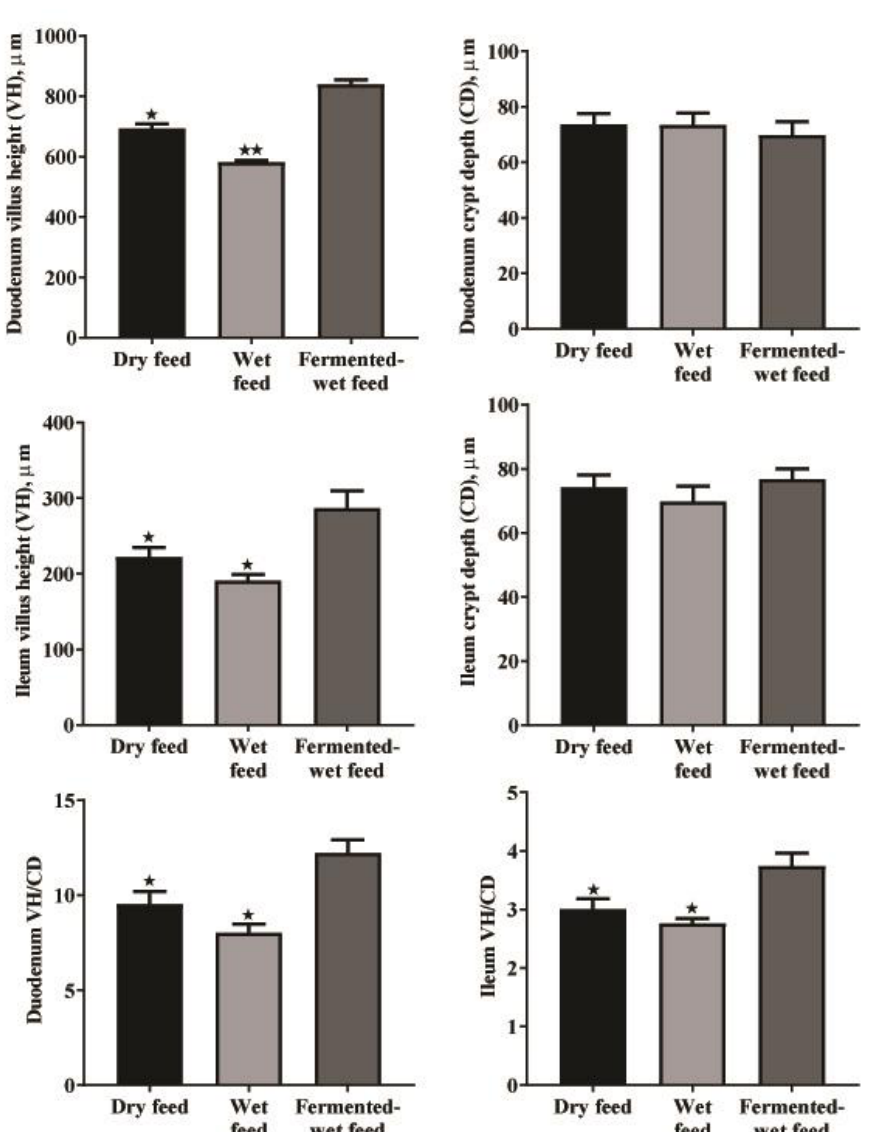
Figure 4. Duodenal and ileal histomorphometry of 35-day-old broiler chickens as affected by dry, wet and fermented wet feeds. Data are presented as the mean values with their standard errors. (*) indicates ( p < 0.05), (**) indicates ( p < 0.01). Asterisk located above the columns indicates signifi- cance between different treated groups and the fermented wet feed group. ( n = 8).